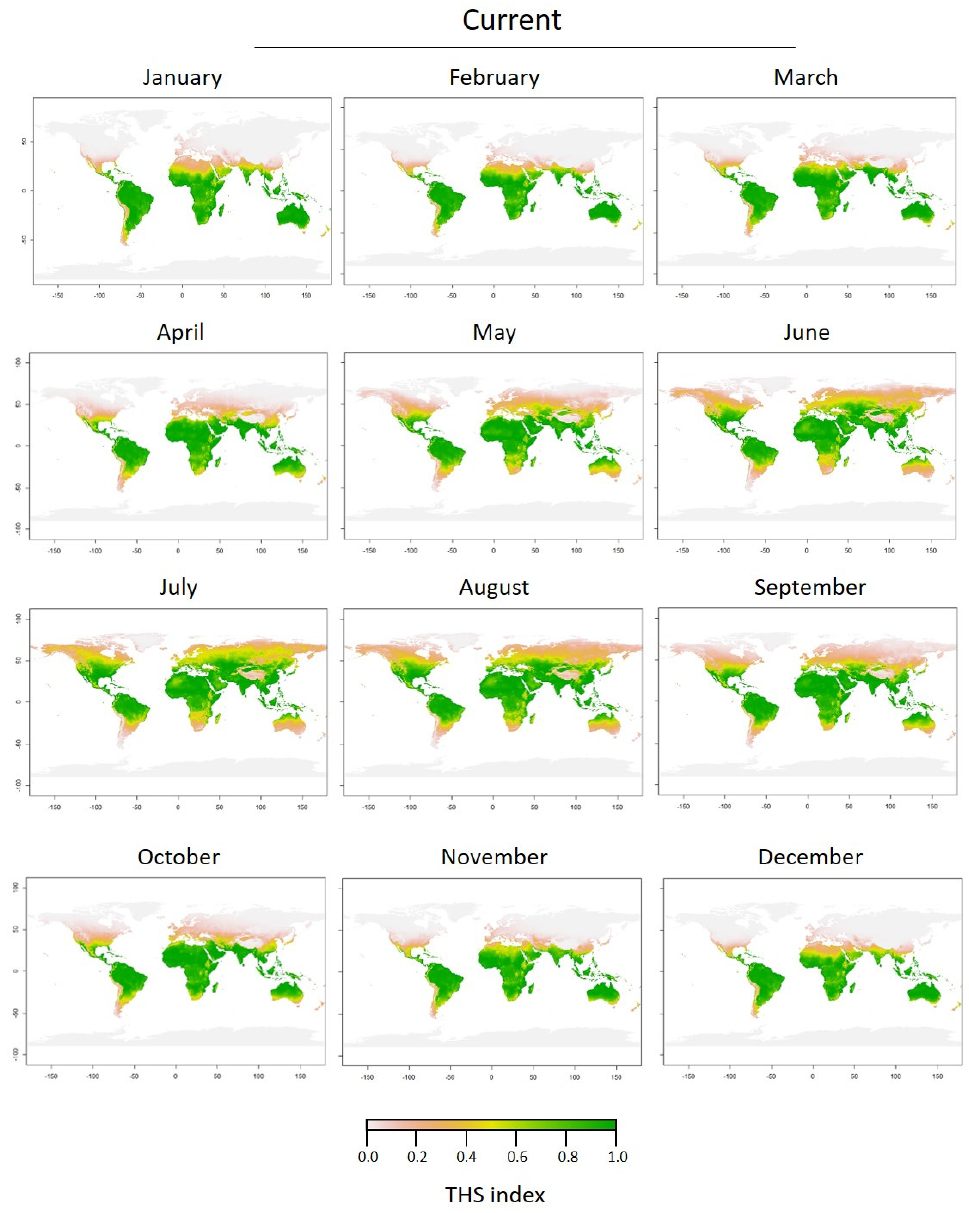
Figure 5. Current (2019) monthly predictions of Thermal Habitat Suitability (THS) of the medusa stage of Craspedacusta sowerbii based on the Thermal Performance Curve (TPC) performed on the activity rate (pulsations min − 1 , lower panel).